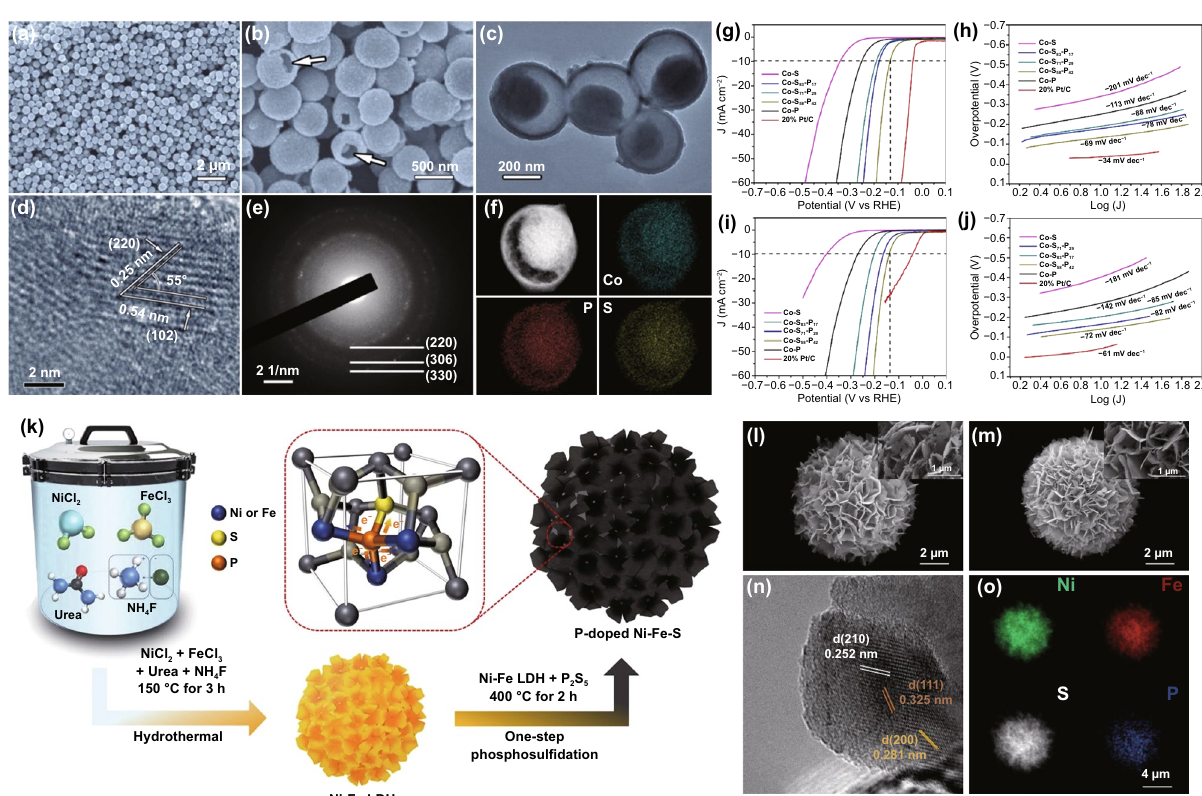
Fig. 10 a SEM, b expanded SEM view. c TEM image. d High-resolution TEM image. e SAED pattern. f STEM image and elemental map- ping of the Co 0.9 S 0.58 P 0.42 yolk-shell spheres. g–j Electrocatalytic performance of different catalysts for HER in alkaline and acidic electrolytes. g Polarization curves and h Tafel plots in 0.5 M H 2 SO 4 . i Polarization curves and j Tafel plots in 1 M KOH. Reprinted with permission from Ref. [64]. Copyright Year 2017. American Chemical Society. k Schematic illustration of the preparation of the P-doped Ni–Fe–S microspheres. High-magnification SEM images of l Ni–Fe–S, and m P-doped Ni–Fe–S, n HRTEM image of the P-doped Ni–Fe–S, o EDS elemental mapping of the P-doped Ni–Fe–S. Reprinted with permission from Ref. [151] Copyright Year 2021.